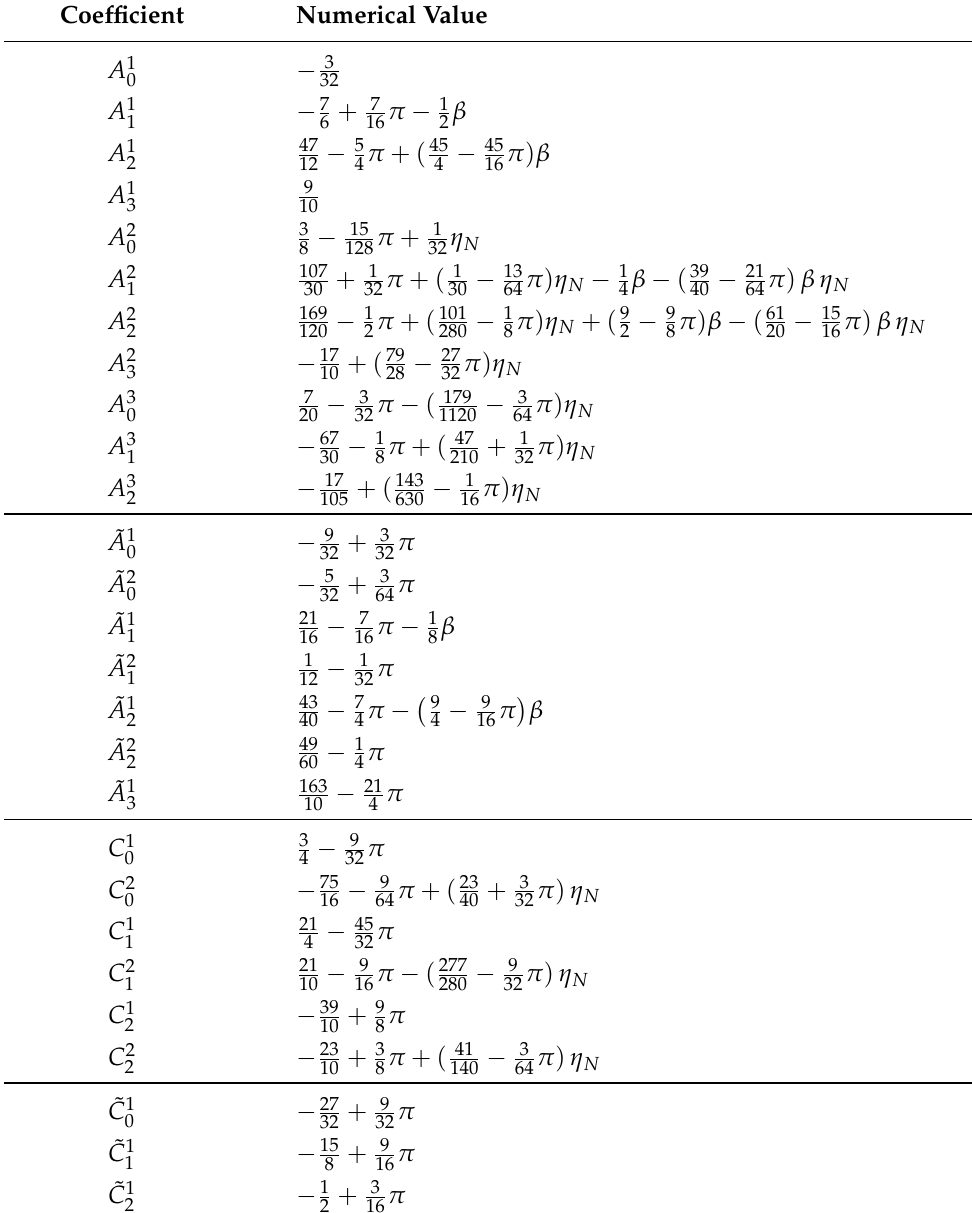
agree with the ones published in i